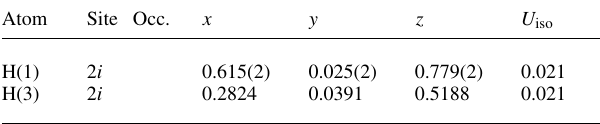
Table 2. Atomic coordinates and displacement parameters (in Å 2 )